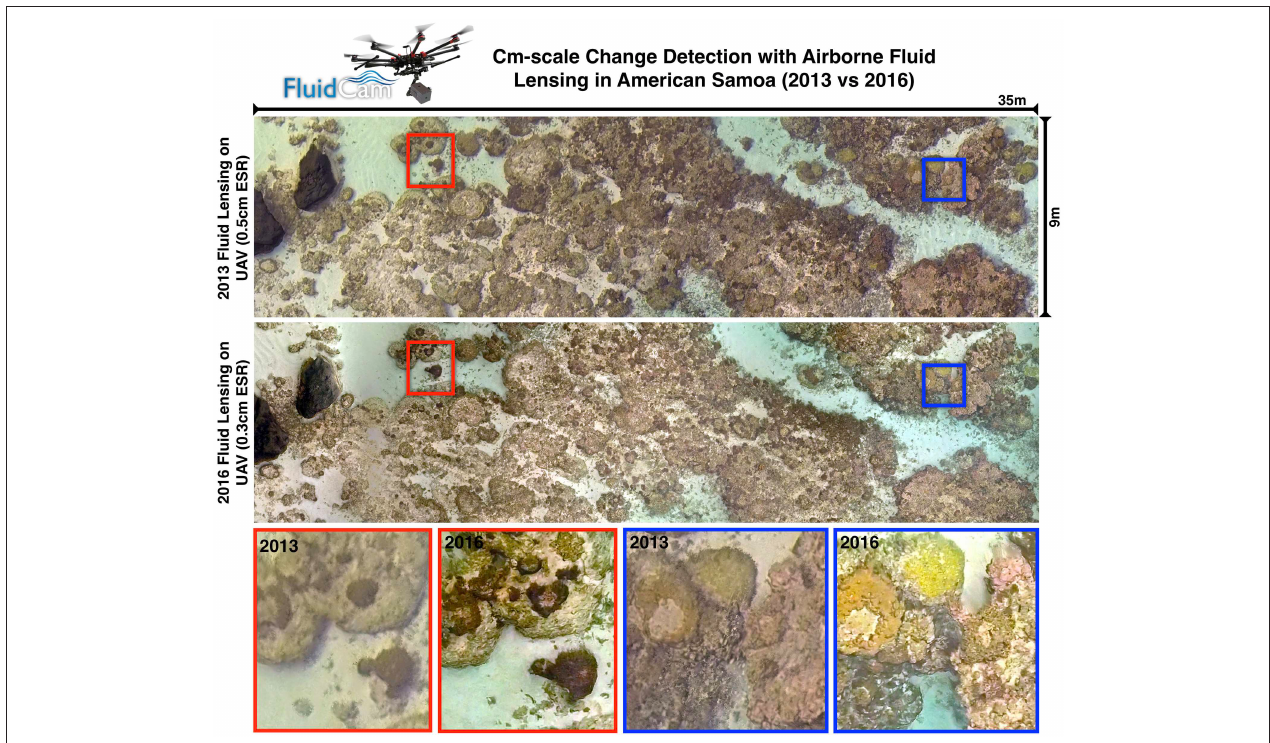
FIGURE 7 | Cm-scale change detection from airborne fluid lensing in American Samoa. Here, 2013 airborne fluid lensing data from a patch of reef are compared with a repeat survey in 2016 showing cm-scale changes in the reef. Color coded regions compare similar areas in each image and show a change in ratio of coral types as well as coral cover. The increased ESR and improved SNR of the 2016 data reflect software and hardware advances in the development of the FluidCam